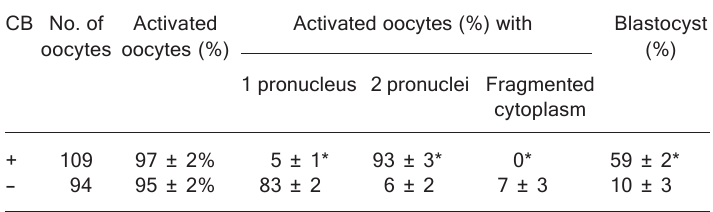
Figure 2. Resumption of meiosis induced by con- ditioned medium (CM) and effects of cytochalasin B (CB) on spindle rotation and pronucleus forma- tion. Microtubules (green) and chromatin (red) were stained with anti-tubulin antibodies and pro- pidium iodide, respectively. After 40-min exposure to CM, MII arrested oocytes in cumulus-oocyte complexes (COCs) resumed meiosis. A, At 1-3 h post-activation in the absence of CB, the first po- lar body (Pb1) extruded into the perivitelline space while the telophase spindle showed an orientation perpendicular to the plasma membrane, and daughter chromosomes separated towards the two spindle poles (SP). B, At 1 to 4 h of CB treatment, the oocytes failed to undergo spindle rotation. C and D, At 0 to 2 h post-CB treatment, because the second polar body (Pb2) extrusion was inhibited, two pronuclei (PN) containing mul- tiple nucleoli formed in the cytoplasm connected with a midbody (MB). Scale bar = 20 μ m for all panels.